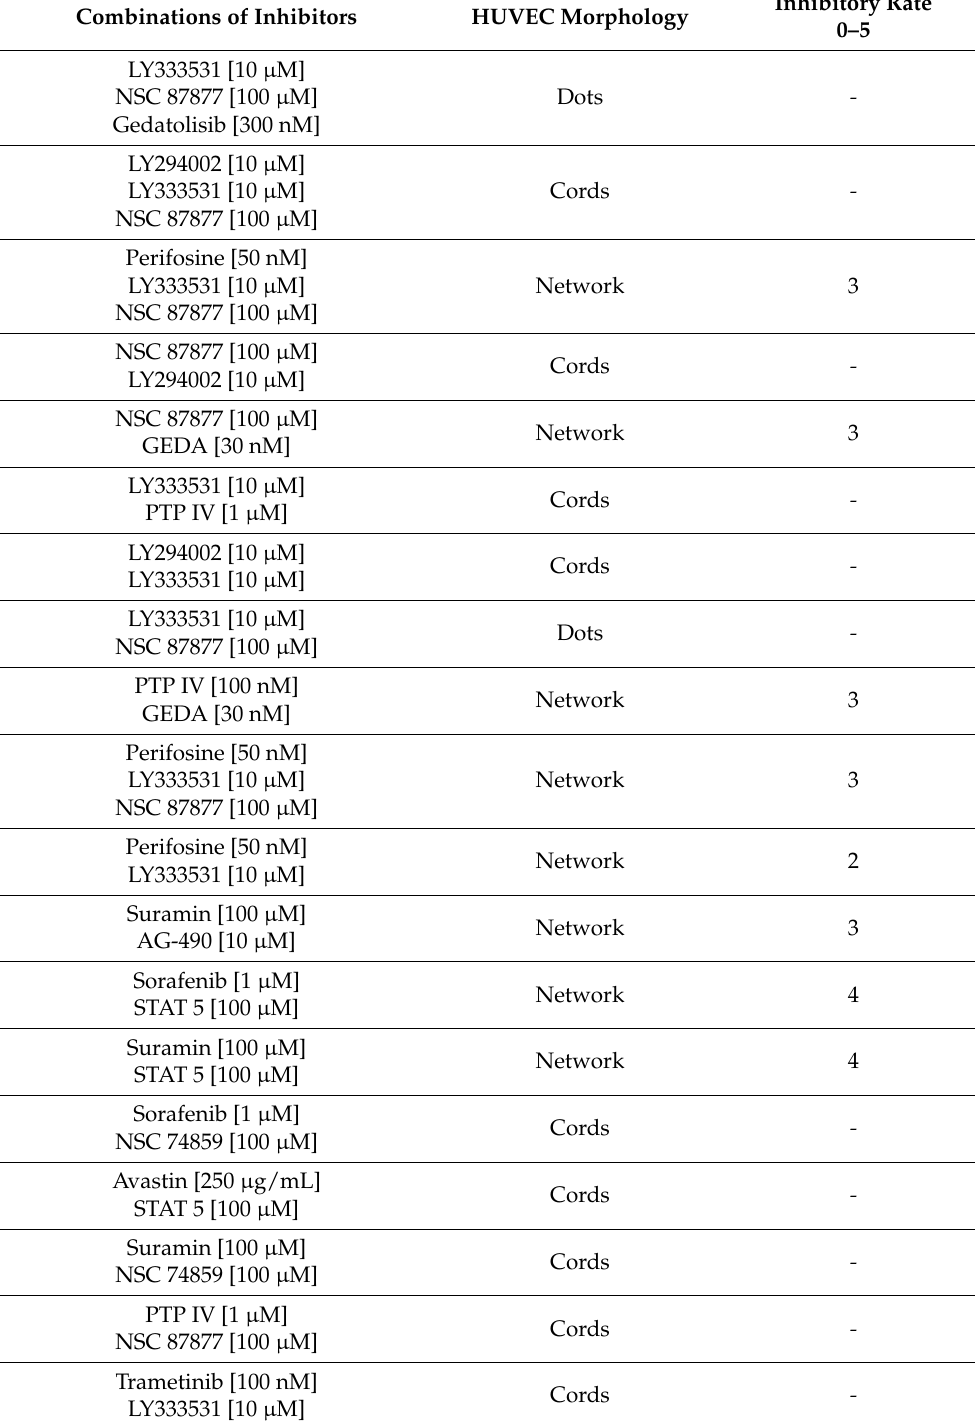
Table 2. Effect of combinations of inhibitors on HUVECs. Inhibitory rate is only given in relation to degree of network